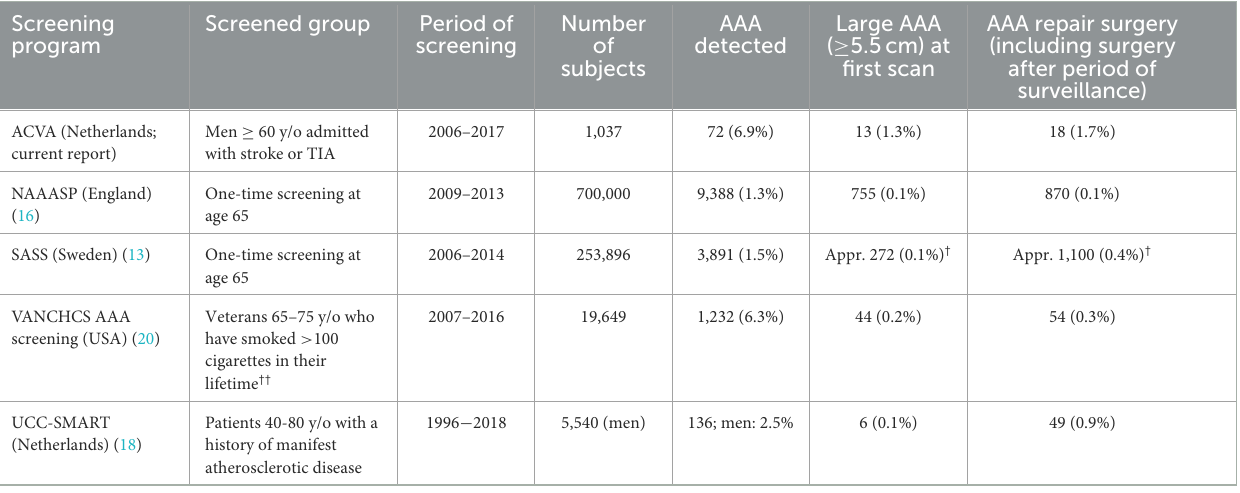
TABLE 1 Comparison of outcomes between known screening